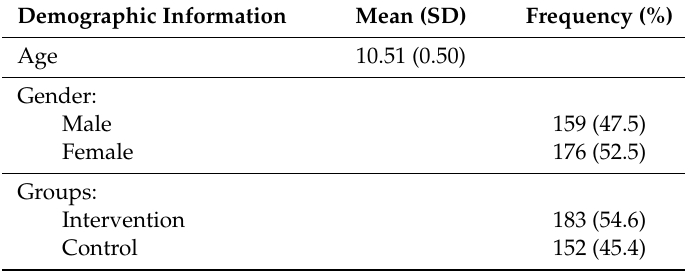
Table 1. Descriptive data of the participants ( n = 335). SD = standard